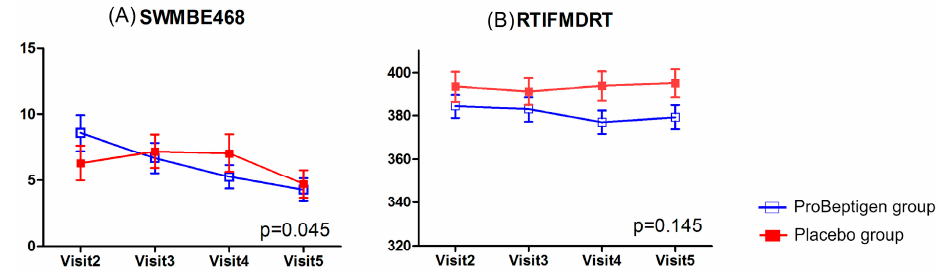
Figure 4. CANTAB including ( A ) spatial working memory (SWMBE468) and ( B ) reaction time task median five-choice reaction time (RTIFMDRT) results. Error bars represent standard errors. The p -value shown in each diagram denotes the statistics of time × treatment interaction after considering the baseline data as a covariate. Lower scores indicate better